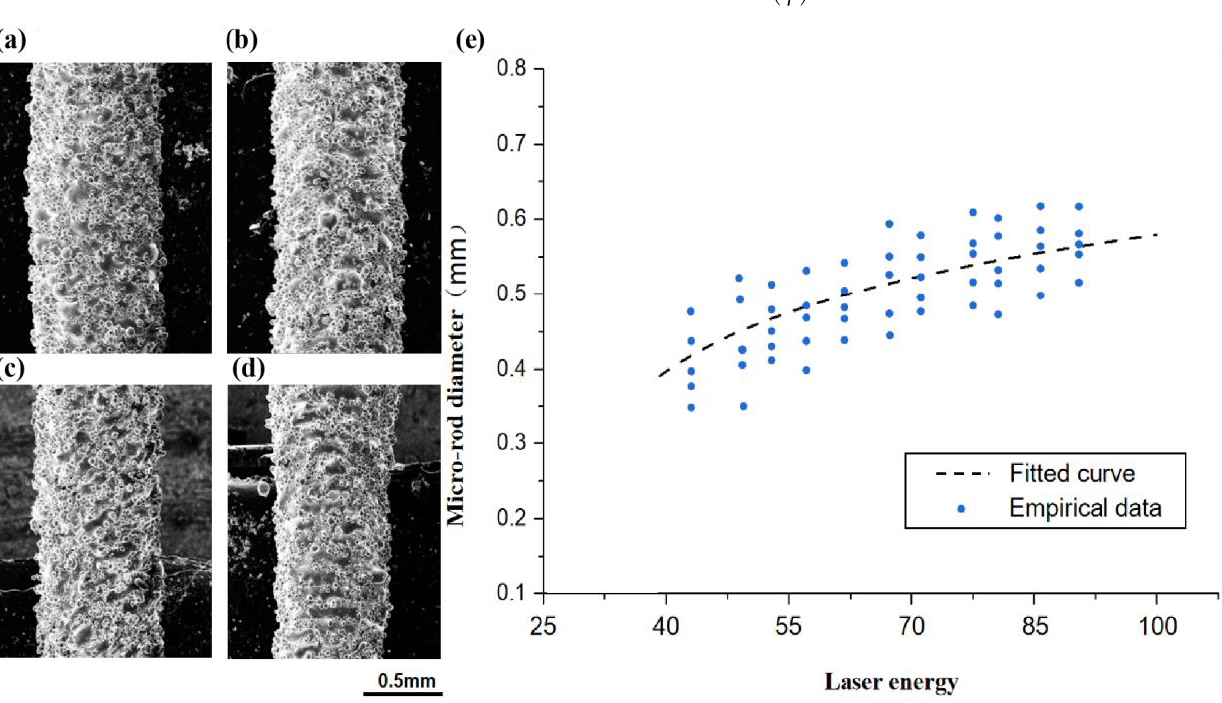
Figure 6. SEM images of the micro-rods using 𝜓 values of 69 𝐽/𝑚𝑚 3 ( a ), 65.2 𝐽/𝑚𝑚 3 (𝐛) , 65.2 𝐽/𝑚𝑚 3 ( c ), and 65.2 𝐽/𝑚𝑚 3 ( d ), respectively, and the relationship between micro-rod diame- 65.2 J/mm 3 ( c ), and 65.2 J/mm 3 ( d ), respectively, and the relationship between micro-rod di- ter and laser energy ( e ). ameter and laser energy ( e